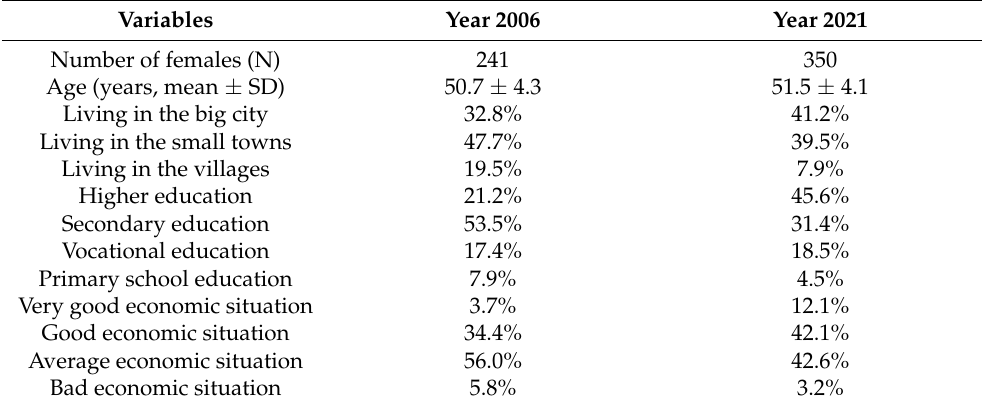
Table 1. Socio-demographic data of